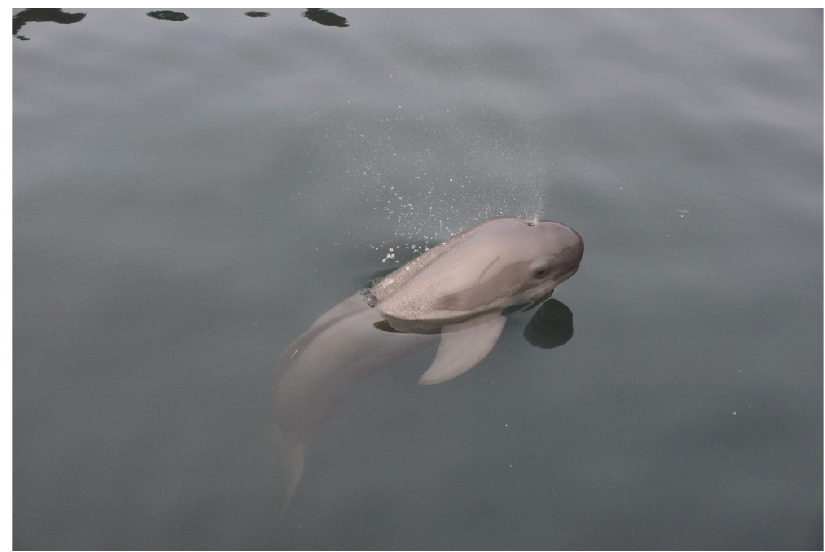
Figure 1. An image of a finless porpoise, N. phocaenoides , taken by Hyun Woo Kim.